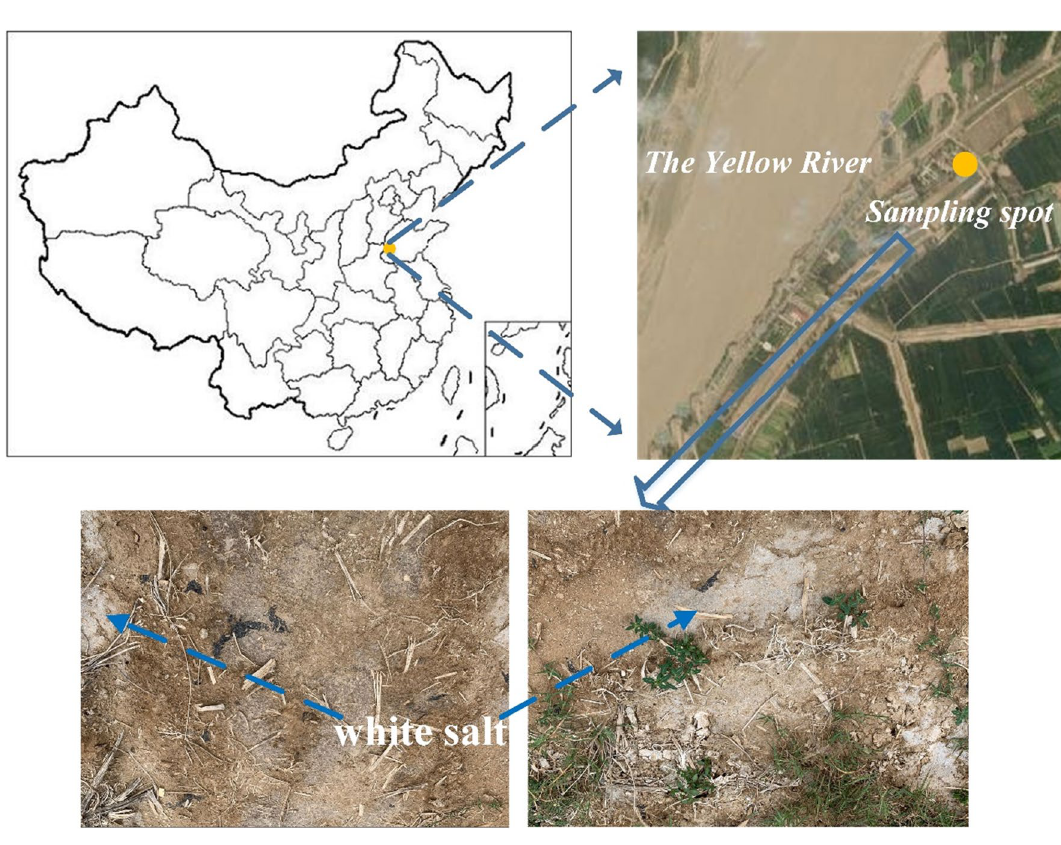
Figure 1. Study area and sampling